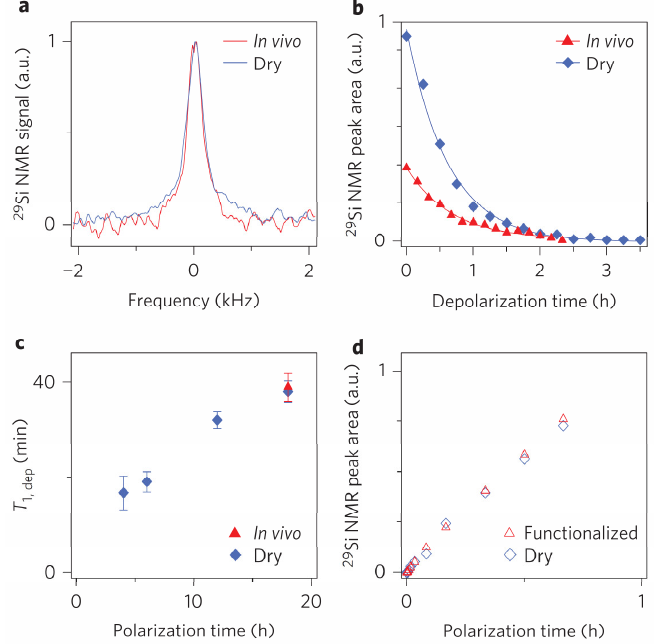
Figure 15. 29 Si nuclear spin dynamics in silicon particles. ( a ) 29 Si NMR spectrum of hyperpolarized particles recorded in vivo and dry at 30 min delay. ( b ) Decay of 29 Si nuclear polarization in hyperpolarized Si particles recorded in vivo and dry. Both plots show a characteristic decay of T 1,dep ≈ 40 min for hyperpolarization time τ pol =8 h using variable flip angle acquisition. The difference in absolute signal is mainly due to the reduced concentration within the active region of the coil. ( c ) Characteristic 29 Si depolarization time constants ( T 1,dep ) in dry particle phantoms recorded in the imager for polarization times of 4, 6, 12 and 18 h. ( d ) Time evolution of the 29 Si nuclear polarization under DNP conditions for particles with and without surface functionalization with polyethylene glycol. The signal is normalized by sample weight. (Reprinted by permission from Springer Nature [25], © (2013)). Appl. Sci. 2020 , 10 , x FOR PEER REVIEW